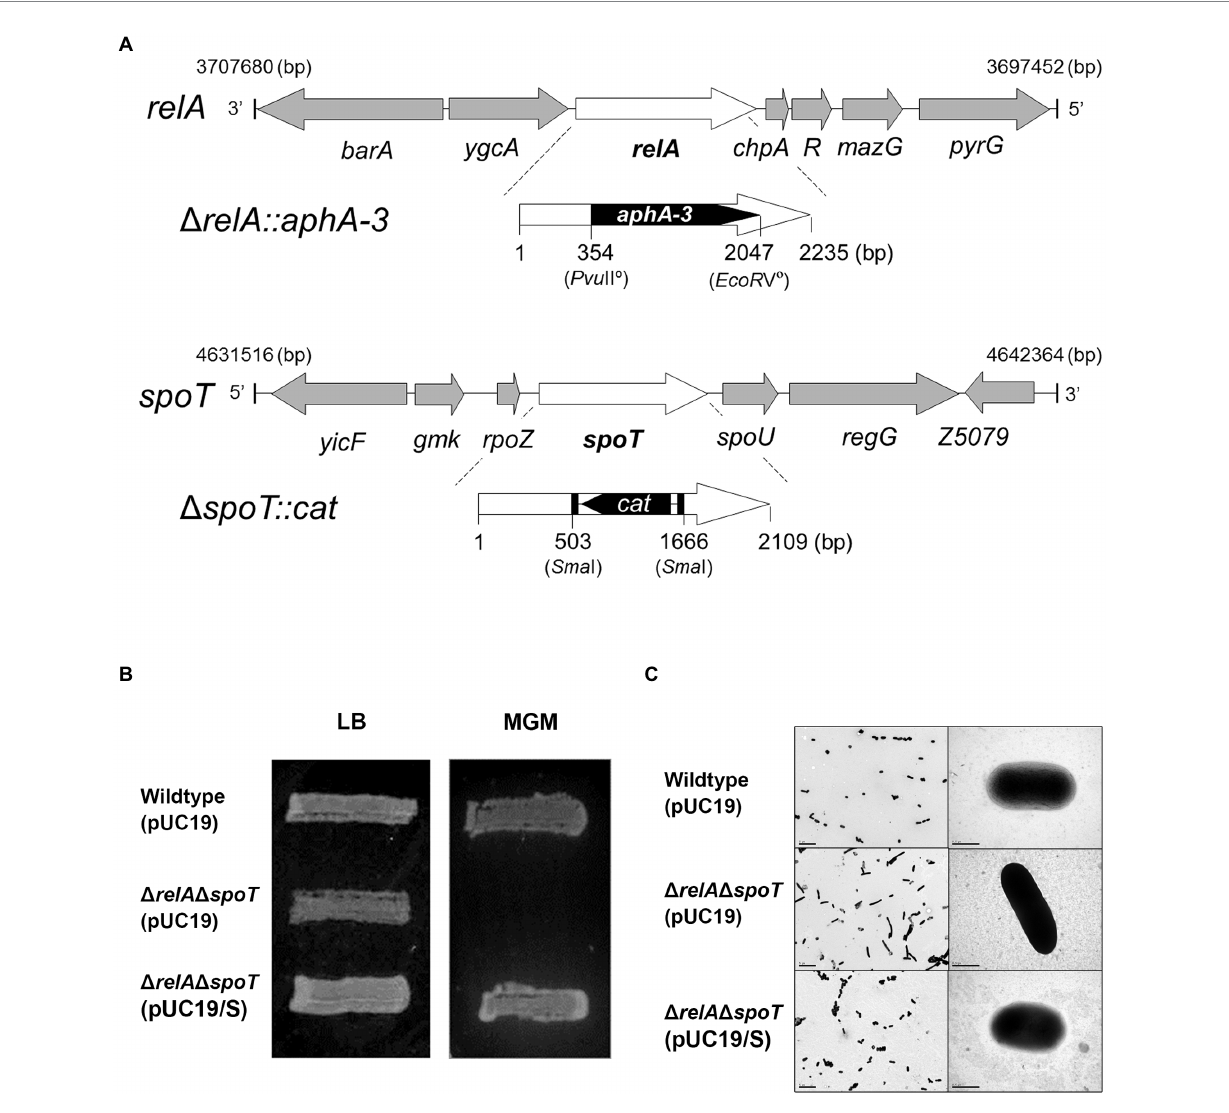
FIGURE 1 Defined mutation of both relA and spoT genes encoding a ppGpp synthetase in EPEC. (A) Mutation of the two ppGpp synthetase genes, relA and spoT , in EPEC O127:H6 chromosome. The mutated Δ relA::aphA-3 and Δ spoT::cat were introduced into EPEC O127:H6 strain E2348/69. (B) The ppGpp- dependent growth on a minimal glucose (MG) medium. Cells were streaked on an MG agar plate and grown at 37 ° C for 19 h. Wildtype (pUC19), E2348/69 strain carrying pUC19; Δ relA Δ spoT (pUC19), E2348/69 Δ relA Δ spoT mutant carrying pUC19; Δ relA Δ spoT (pUC19/S), E2348/69 Δ relA Δ spoT mutant carrying pUC19/S. (C) The morphological comparison between EPEC strains by using transmissible electron